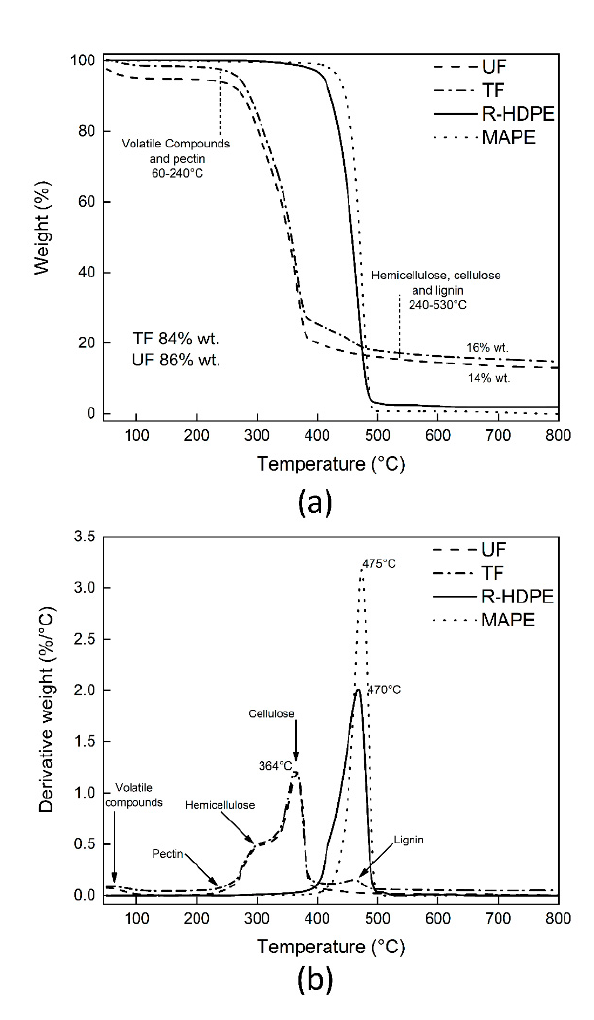
Figure 4. Thermogravimetric analysis ( a ) and the derivative ( b ) curves of the neat materials: maleated polyethylene (MAPE), recycled high density polyethylene (R-HDPE), as well as untreated (UF) and treated (TF) maple fibers under a nitrogen atmosphere.